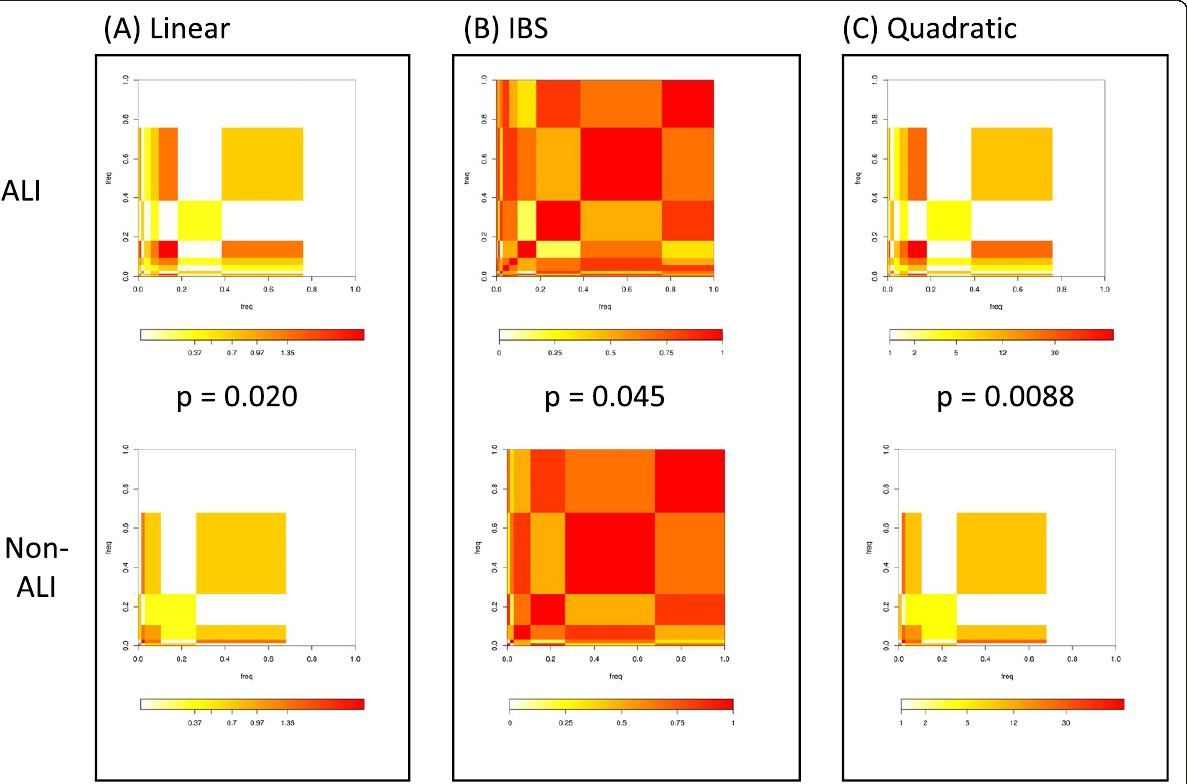
Figure 5 Representative kernel matrix plot of the VEGFA gene in EA subjects. As in Figure 4, the plot displays the frequency of haplotype sharing within ALI cases or non – cases, where size of the cell reflects the overall haplotype frequency and the red coloration reflects the degree of similarity among group members. In the case of VEGFA, both the coloration and block structure of ALI cases are most distinct with the quadratic function, and this is reflected in the most extreme p- value for the quadratic kernel